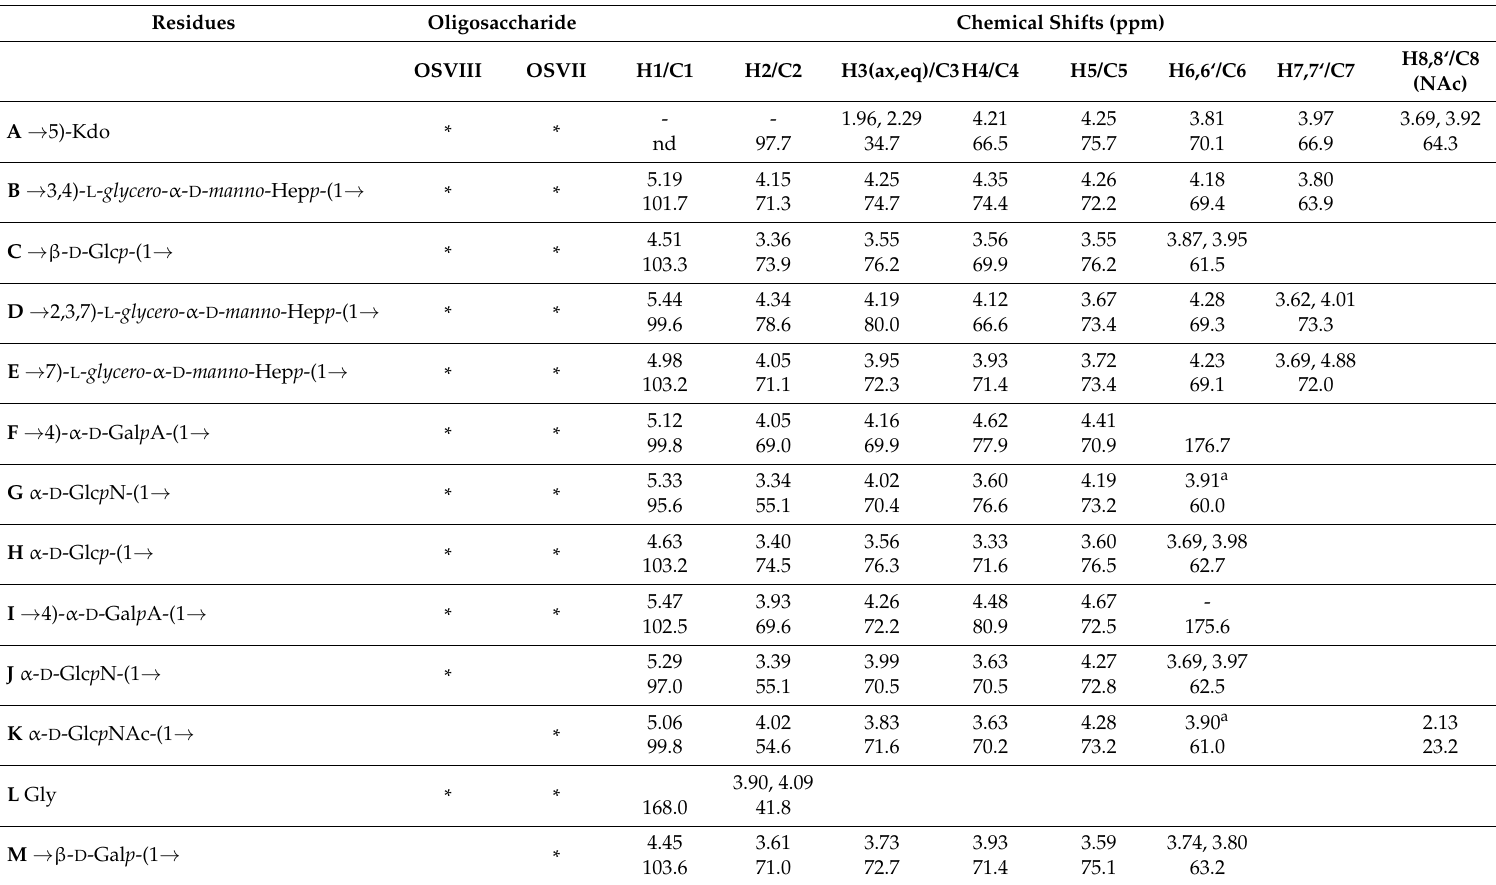
Table 1. 1 H and 13 C NMR (nuclear magnetic resonance) chemical shifts of the core oligosaccharide of E. tarda EIB 212 LPS.